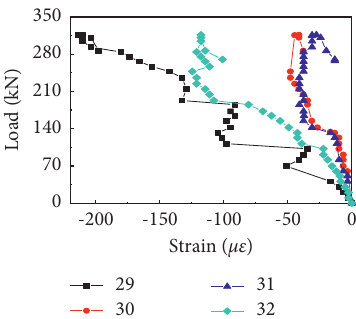
Figure 20: Load-strain curves at measuring points 29 to 32 of test piece 1-A.